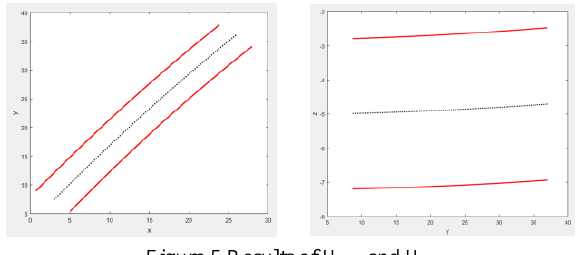
Figure 5 Results of U xoy and U yoz